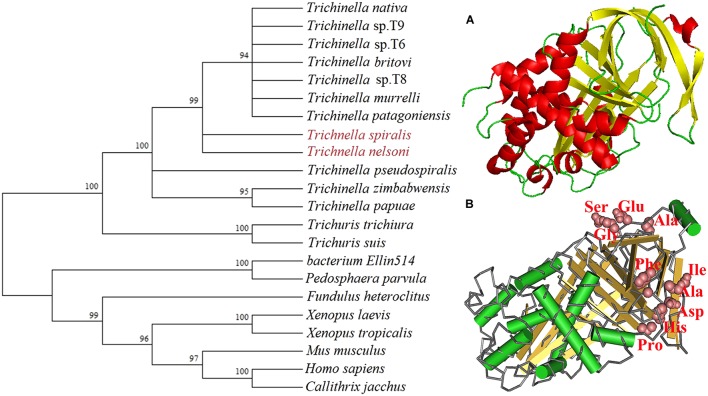
Phylogenetic trees of serine protease inhibitors (SPI) of 22 organisms with the NJ method and mapped with MEGA (left) and the predicted three-dimensional structure of T. spiralis TsSPI protein (right). (A) The predicted three-dimensional structure of TsSPI protein contains 9 α-helixes (in red) and 12 β-strand (in yellow). (B) The functional domain with an active site carrying a classic SPI reactive central loop (RCL) consisted of ten amino acids. The active site of TsSPI is marked on pink.